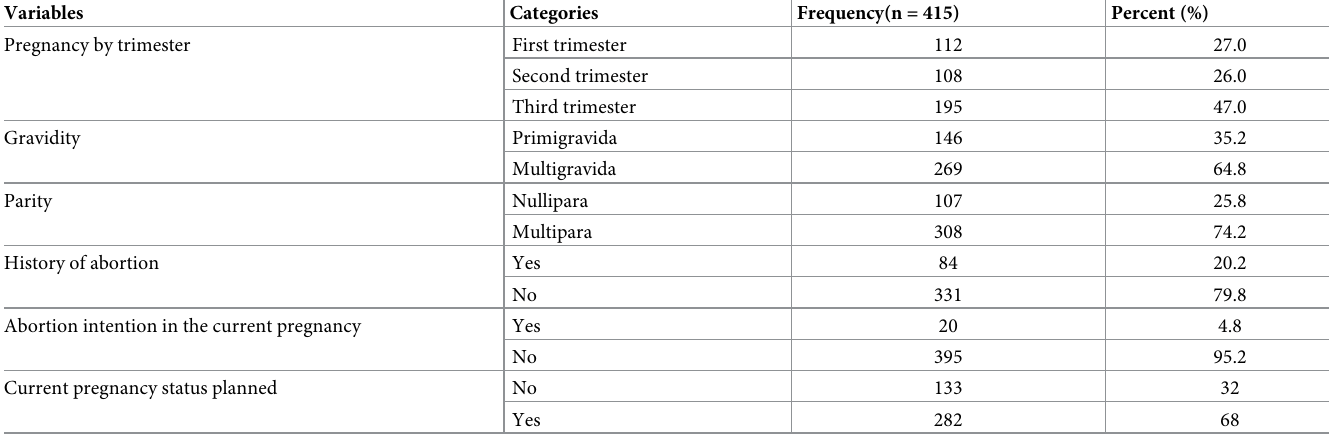
Table 2. Description of obstetrics-related factors among pregnant women attending antenatal care at Jimma medical center, Jimma, Southwest Ethiopia, 2020 (N =